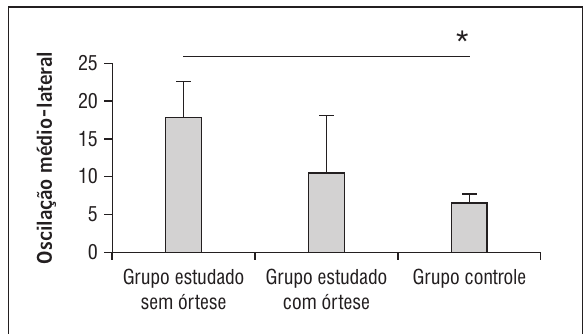
Legenda: ML = médio-lateral e AP = ântero-posterior.